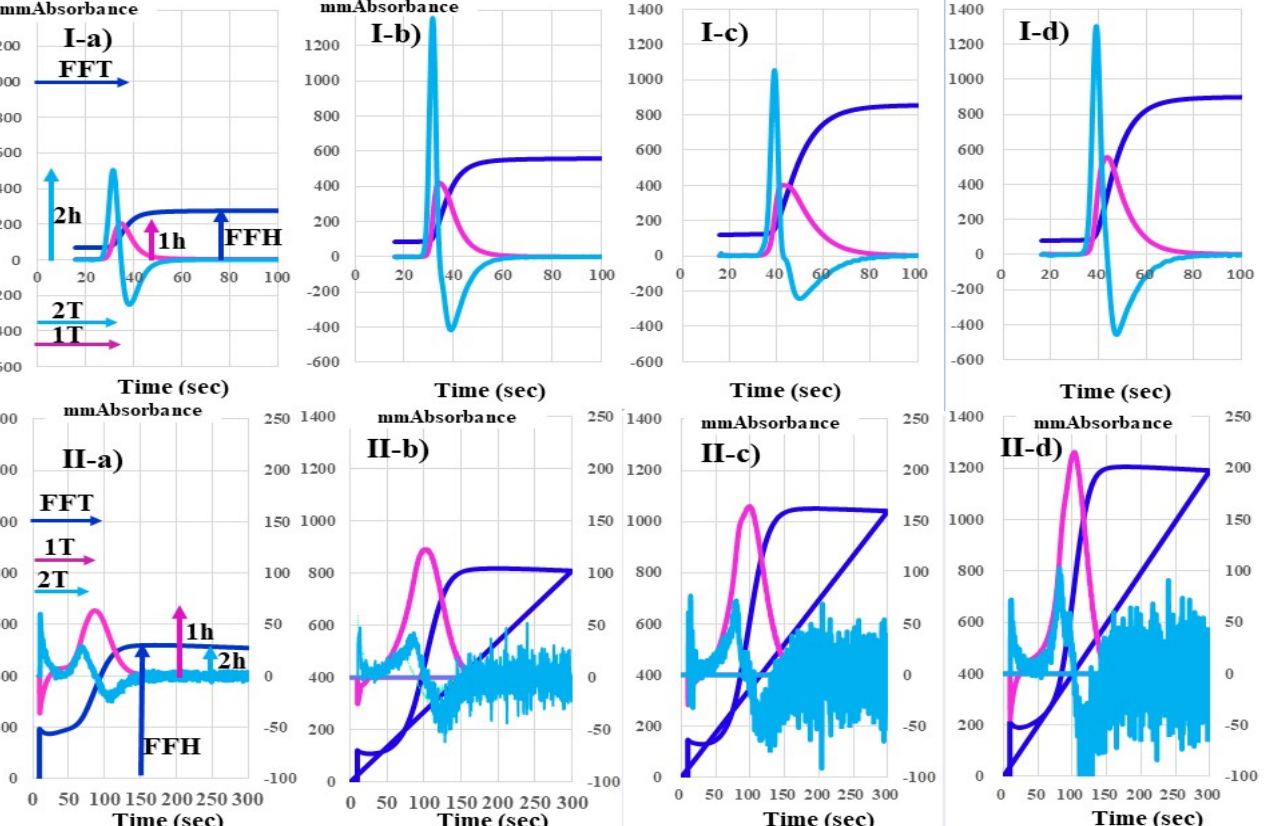
Figure 1. CWA-APTT ( I ) and CWA-sTF-FIXa ( II ) in a healthy volunteer ( a ), pancreatic cancer patient without thrombosis ( b ), pancreatic cancer patient before ACI ( c ) and patient with ACI ( d ). APTT, activated partial thromboplastin time; sTF/FIXa, small tissue factor induced FIX activation assay; ACI, acute cerebral thrombosis; navy line, fibrin formation curve; red line, 1st derivative curve (velocity); light-blue line, 2nd derivative curve (acceleration); 1T, 1st derivative peak time; 2T, 2nd derivative peak time; FFT, fibrin formation time; 1 h, 1st derivative peak height; 2 h, 2nd derivative peak height; FFH, fibrin formation height, TM (mm abs); transmittance (mm absorbance).